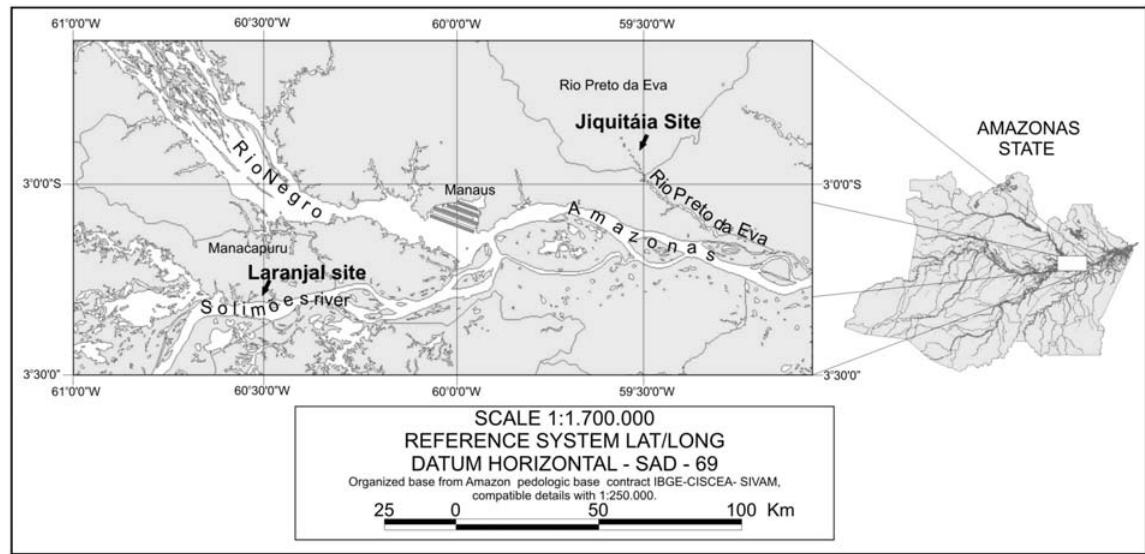
Figure 1. Location of studied